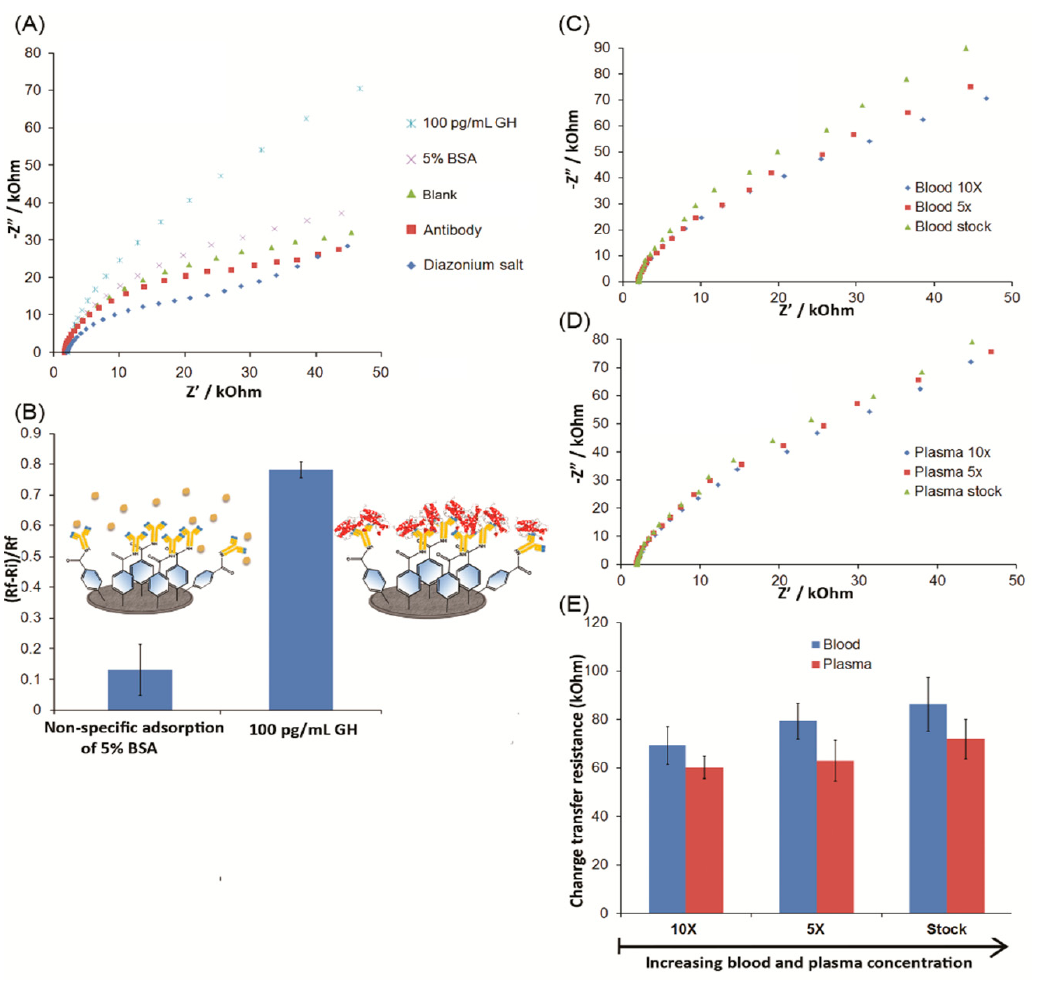
( B ) Dependence of GH concentration on the R ct values obtained from the Randles equivalent circuit at GCE. ( C ) Nyquist plots for the detection of various GH concentrations on screen-printed carbon electrodes (SPCE). ( D ) Dependence of GH concentration on the R ct values obtained from the Randles equivalent circuit at the SPCE. Error bars indicate three consecutive measurements (n = 3) of each GH concentration using renewed GCE surfaces and using a new single-use SPCE.